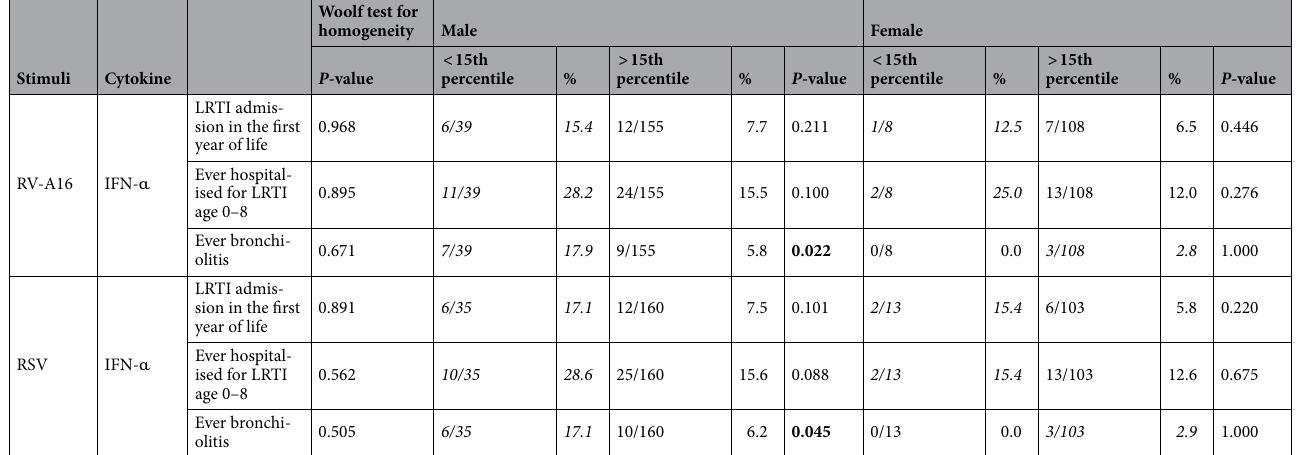
Table 5. Comparisons of LRTI and bronchiolitis hospital admissions in participants with IFN-α responses to RV-A16 and RSV below and above the 15th percentile stratified by sex. Differences stratified by sex were assessed using Fisher exact tests. P values less than 0.05 are in bold. The group with the higher frequency of LRTI hospital admissions and bronchiolitis cases in early life is highlighted in